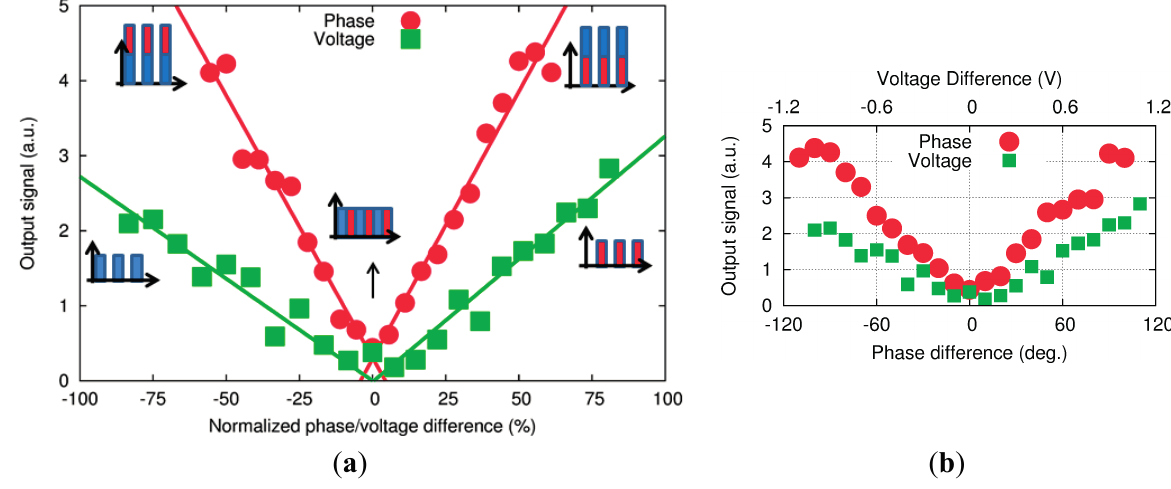
Figure 6. ( a ) PA amplitude signal versus normalized phase difference and voltage with ( b ) the corresponding raw